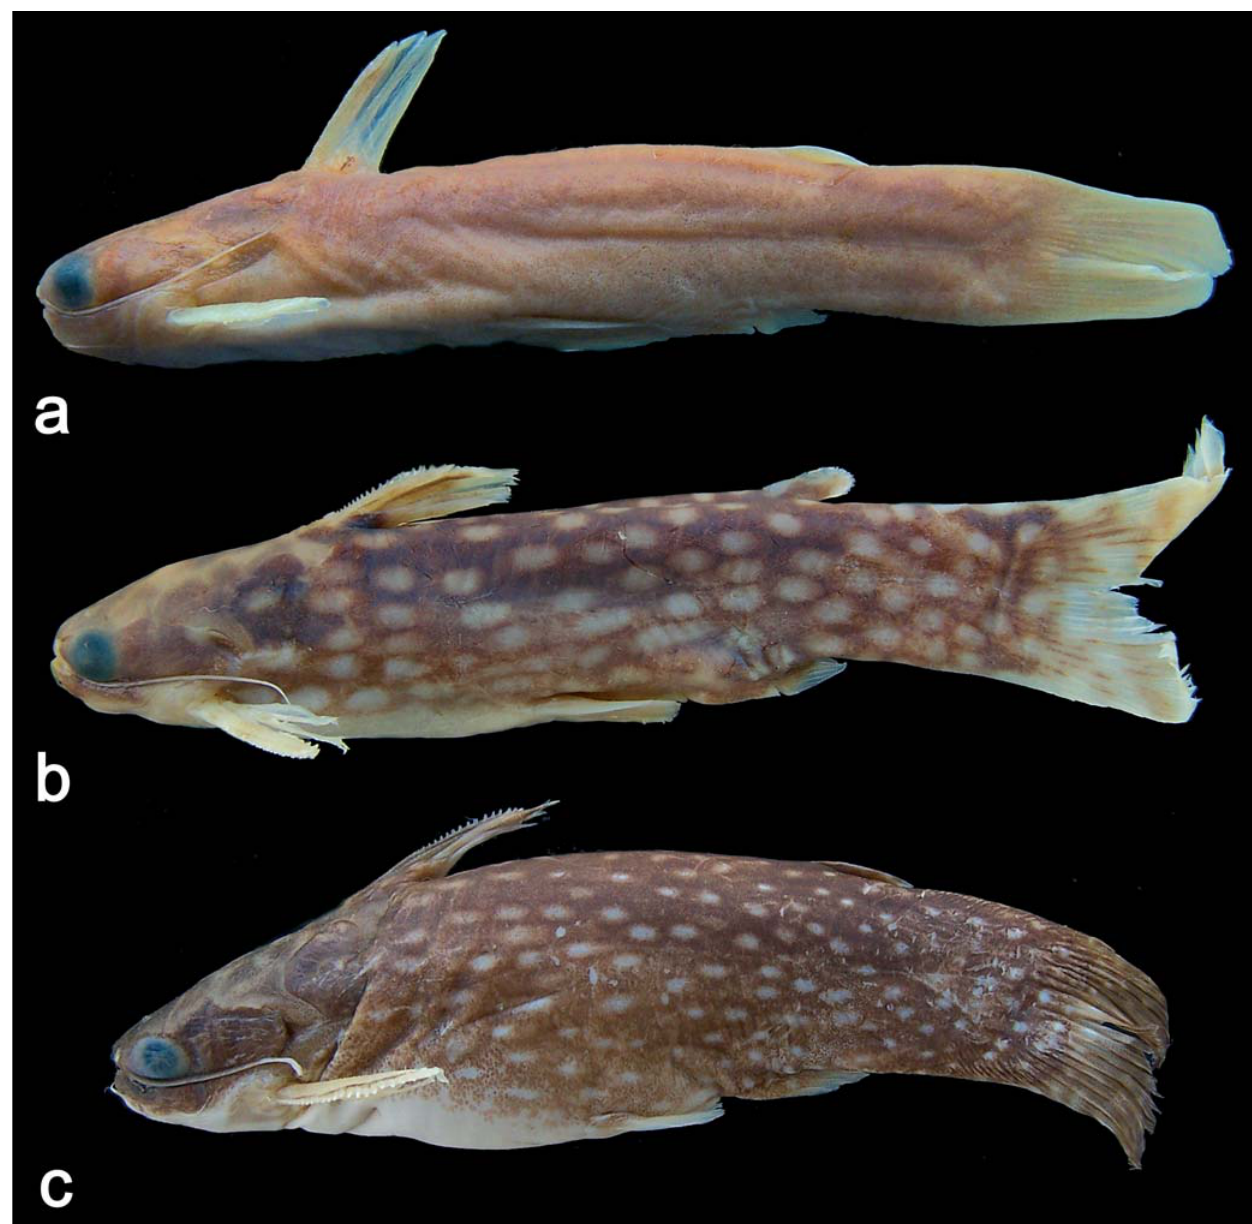
Fig. 27. Tatia intermedia. (a) MZUSP 44255, male, 65.5 mm SL, Capim river, Pará State, Brazil. (b) ZMA 105.523, male, 39.0 mm SL, Gran Mau stream, Suriname. (c) INPA 11076, female, 84.7 mm SL, Tocantins river, Pará State,